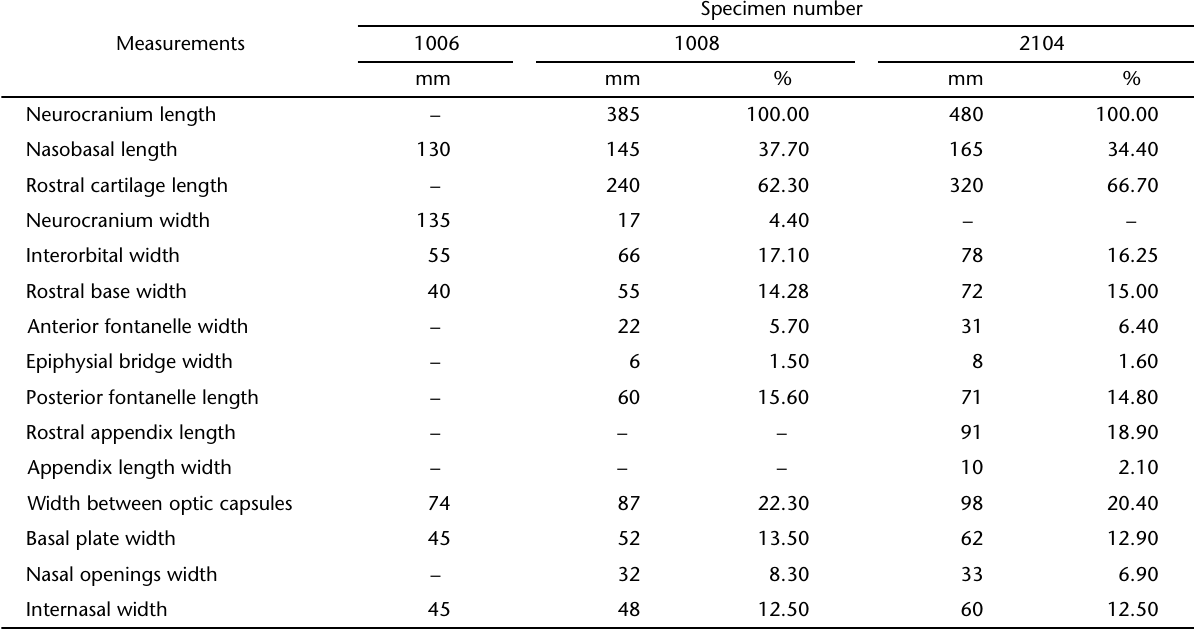
Table IV. Neurocranial measurements (mm) taken from specimens of D. mennii . Percentages are in relation to neurocranial total length; all specimens are from the UERJ